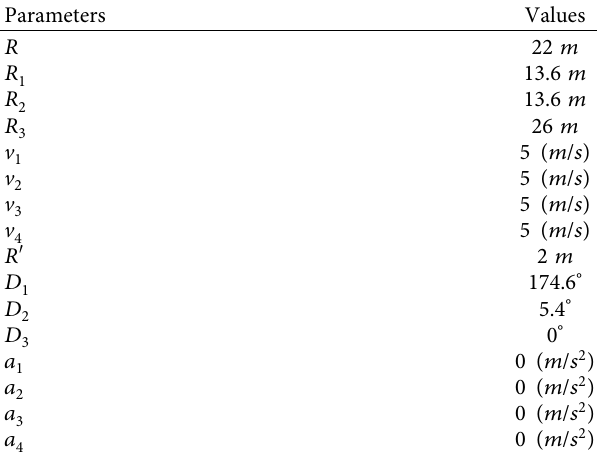
Table 1: Data of the participants in the initial scene.